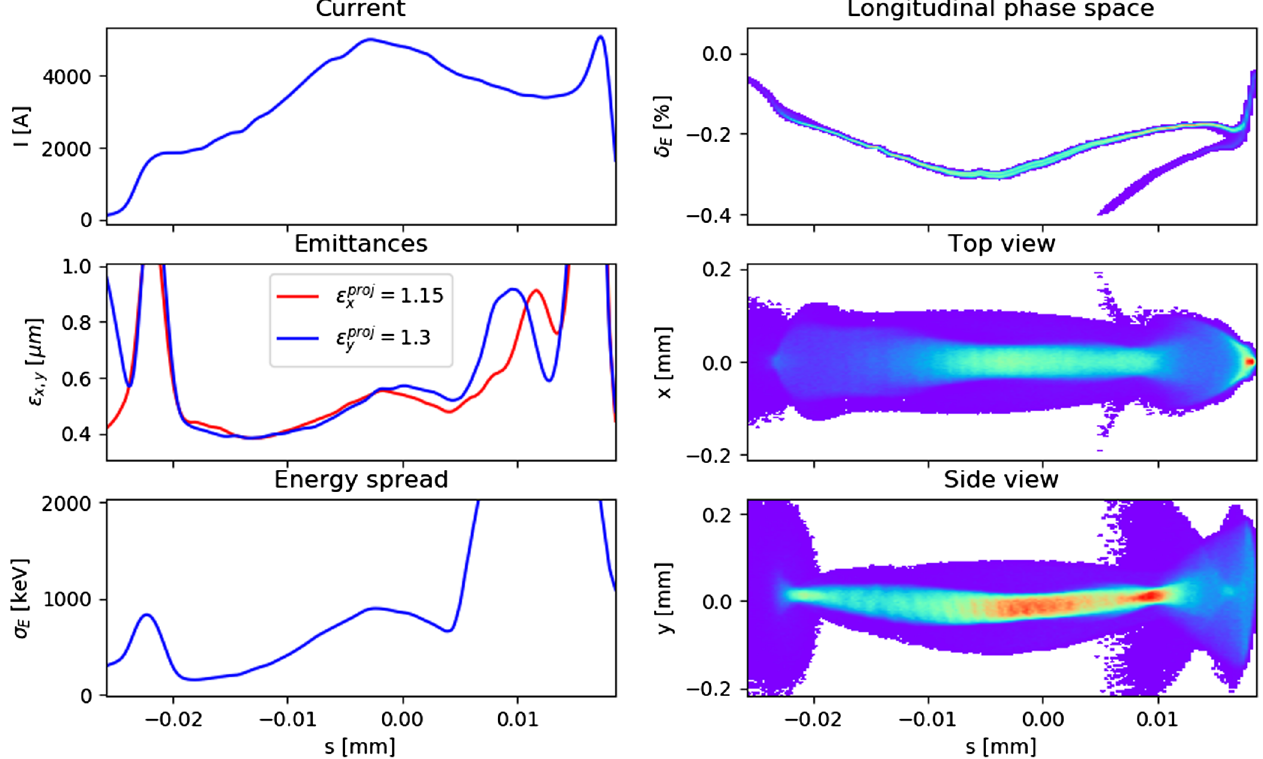
FIG. 8. The properties of the bunch with a charge of 500 pC compressed to 5 kA peak current at the SASE1 line undulator